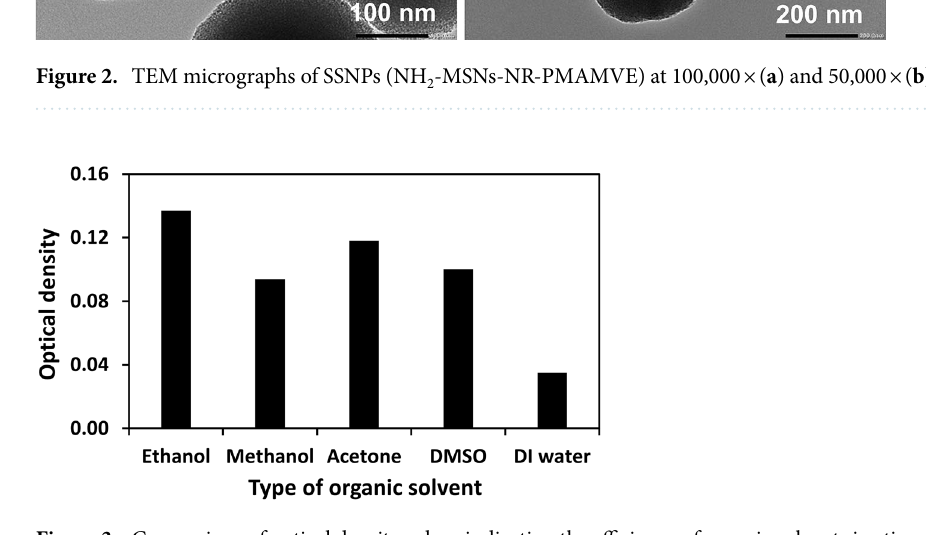
Figure 3. Comparison of optical density values indicating the efficiency of organic solvents in stimulating SSNPs. The optical density was measured at the maximum wavelength of NR in each solvent, which were 553 nm, 585 nm, 580 nm, 585 nm, and 400–600 nm for ethanol, methanol, acetone, DMSO, and DI water,